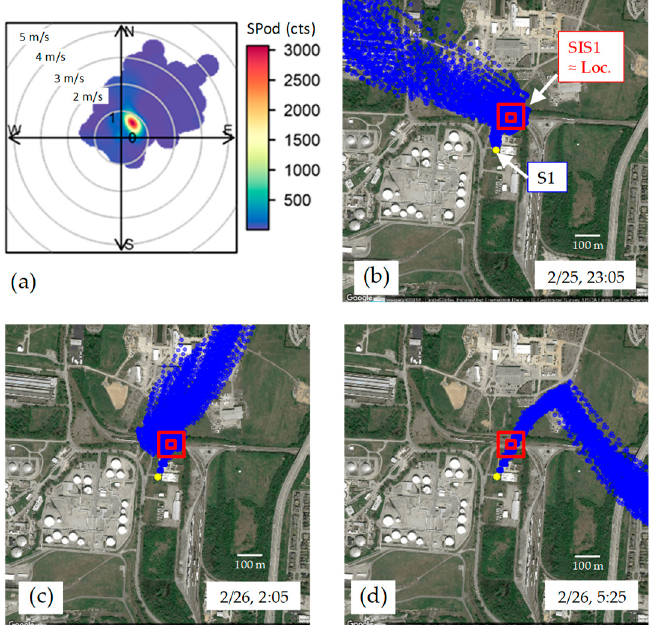
Figure 5. ( a ) S1 SPod source direction indicator (SDI) plot for 22:00 on 2/25/2018 to 11:00 on 2/26/2018 with concentric circles representing wind speed in m/s and color bar SPod PID, and ( b ), ( c ), and ( d ) showing 99 back trajectory paths each for the five-minute BTM runs for 23:05 on 2/25/2018, 2:05 on 2/26/2018, and 5:25 on 2/26/2018, respectively, the highest concentrations of Figure 4. The concentric red boxes represent the near-optimal trial source location from TCTA with the inner box approximating the defined source areas for the TCTA calculation.